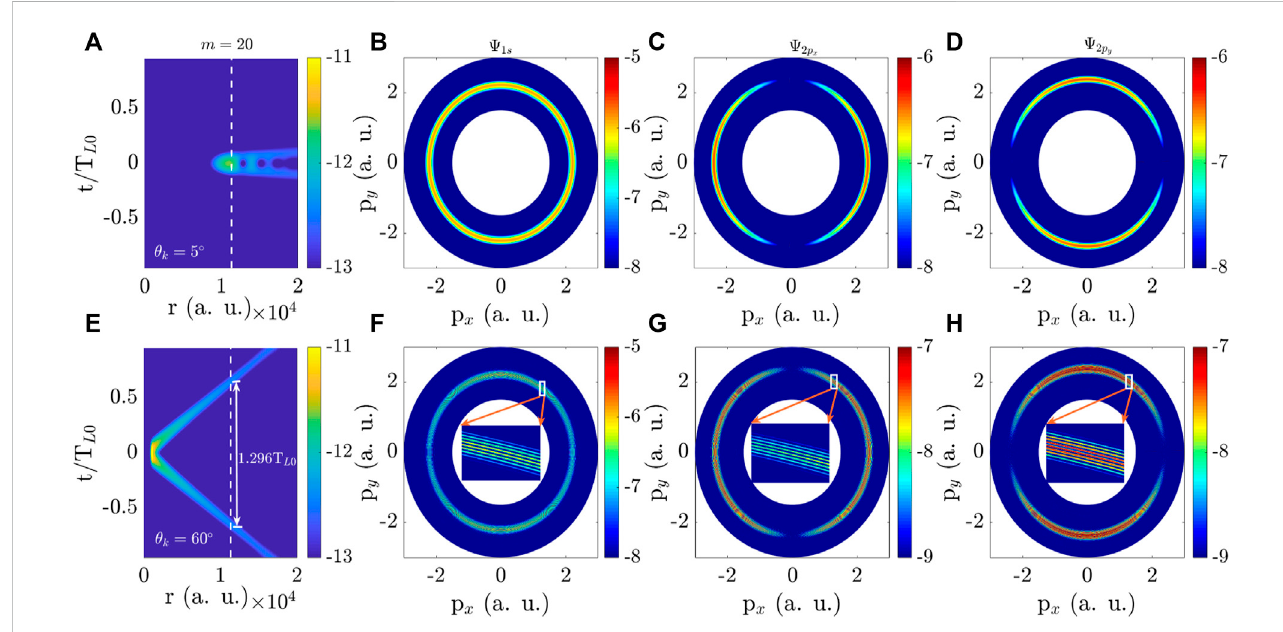
FIGURE 4 Same as Figure 3 but for a different PTAM m = 20 of the X wave. (A – D) θ k = 5 ° and (E – H) θ k = 60 °